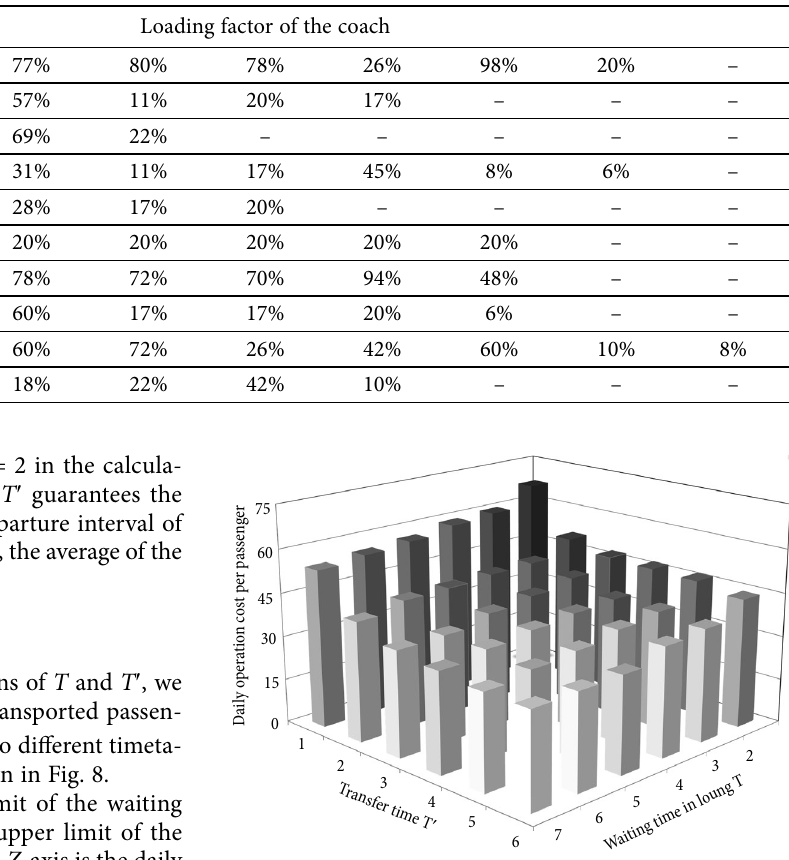
Fig. 8. The influence of the T and T ′ to the unit operation cost per transported